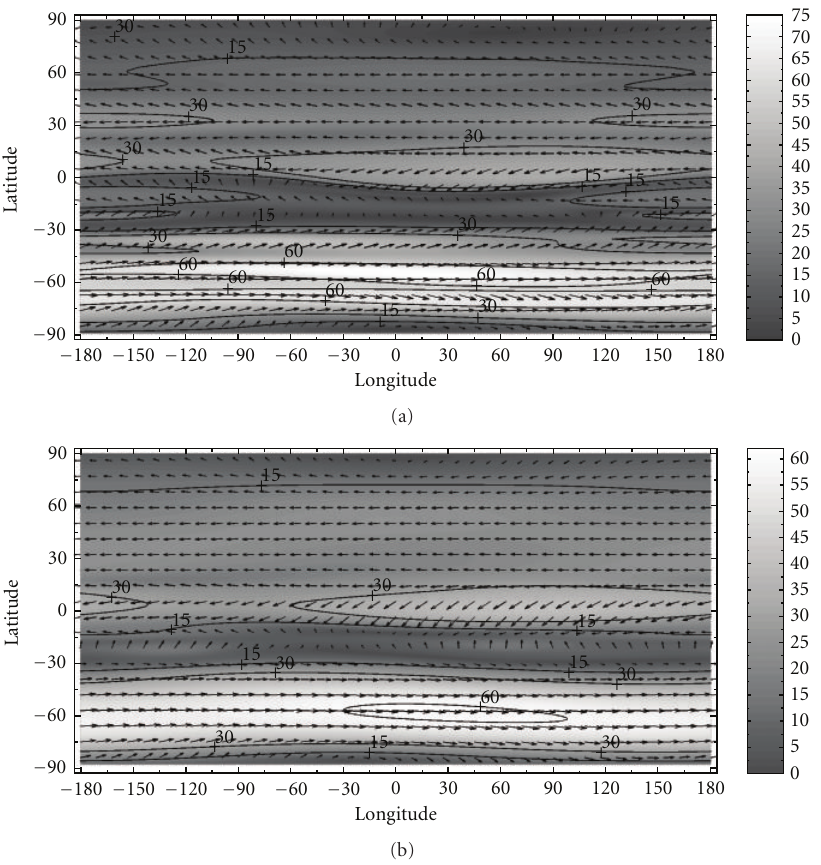
Figure 9: The global distributions of the vector of the simulated horizontal component of the neutral wind velocity at the altitude of 30km, obtained for 16 July and calculated for two distinct values of solar activity: F 10 . 7 = 101 (a) and F 10 . 7 = 230 (b). The velocities are given in m/s.